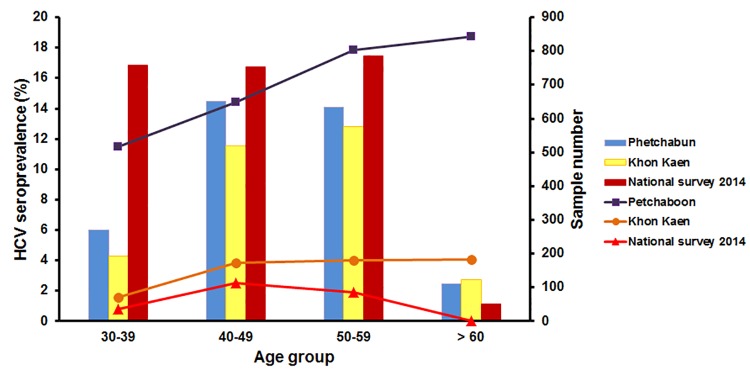
Anti-HCV seroprevalence in Phetchabun and Khon Kaen in this study compared to data from the national survey in 2014.HCV seroprevalence is indicated by the line graphs (left scale). The number of individuals according to age groups included in the study is represented by the bar graphs (right scale).